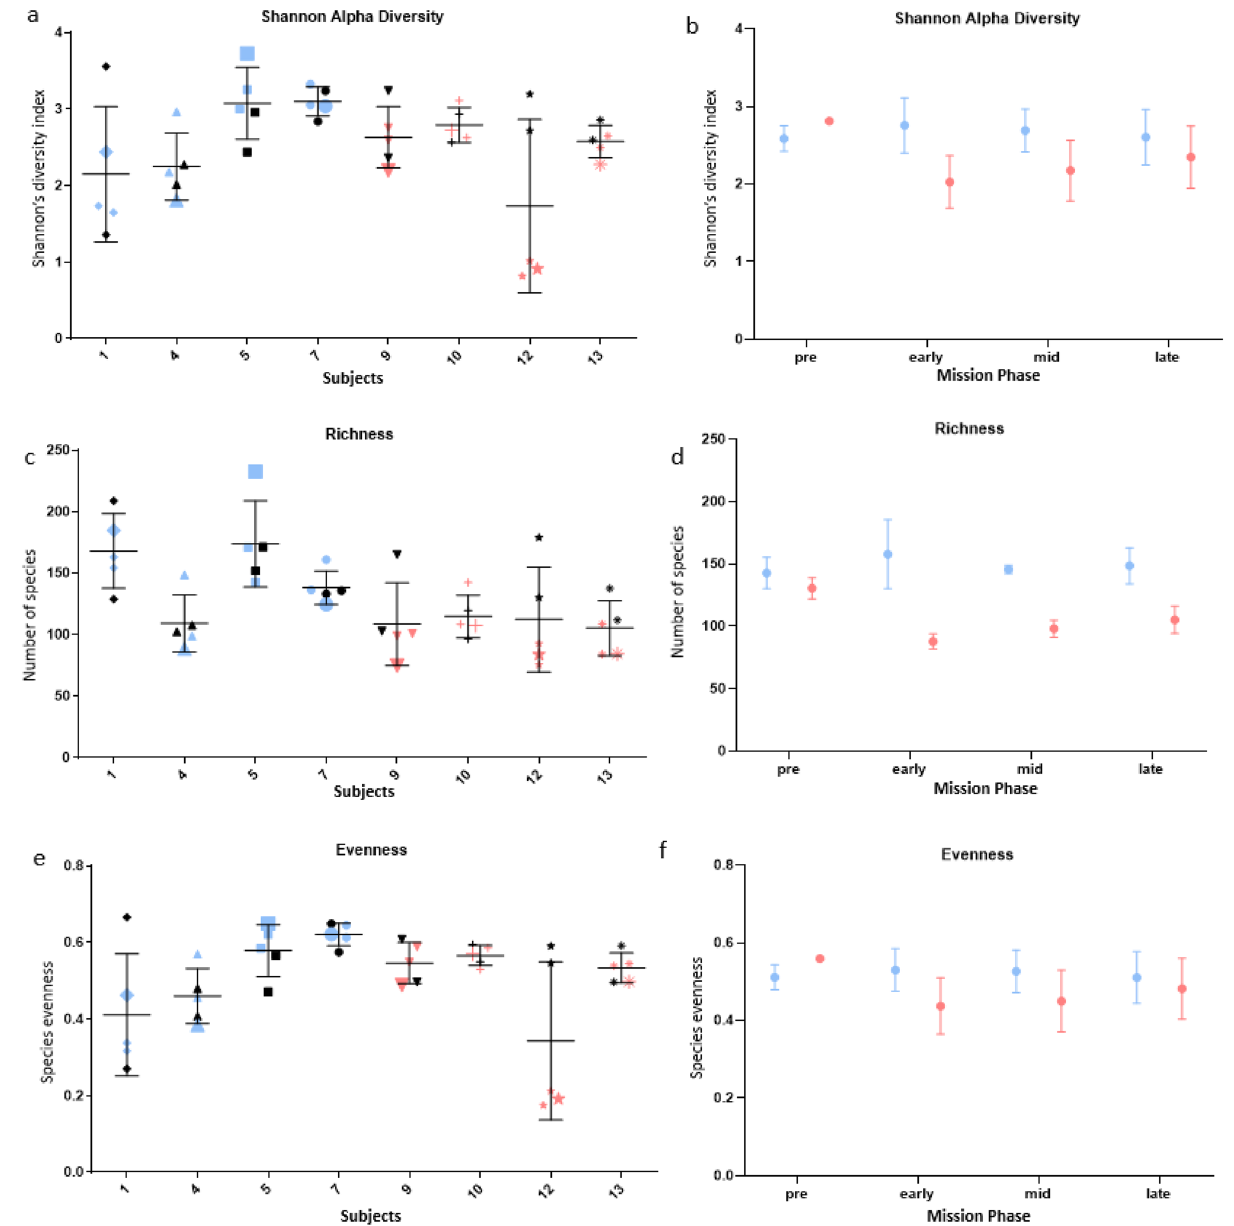
Figure 5. Variation in in-mission alpha diversity compared to pre-mission for a subset of subjects. Alpha diversity was more stable for subjects on the enhanced diet. Reductions in diversity (both richness and evenness) were significant early in the mission for subjects consuming the standard diet but returned to pre-mission levels by the end of the mission. In ( a,c,e ) each vertical set of samples represents one individual on the enhanced diet (blue) or the standard diet (red). Black symbols denote individual pre-mission average. Larger Red and Blue symbols indicate the early time point in-mission, with the most significant change for standard diet subjects. In ( b,d,f ) plots represent changes in alpha diversity mean ± SE of all subjects on the enhanced diet (blue) or the standard diet (red) during different phases of the mission. More information is available in SI Appendix, Table